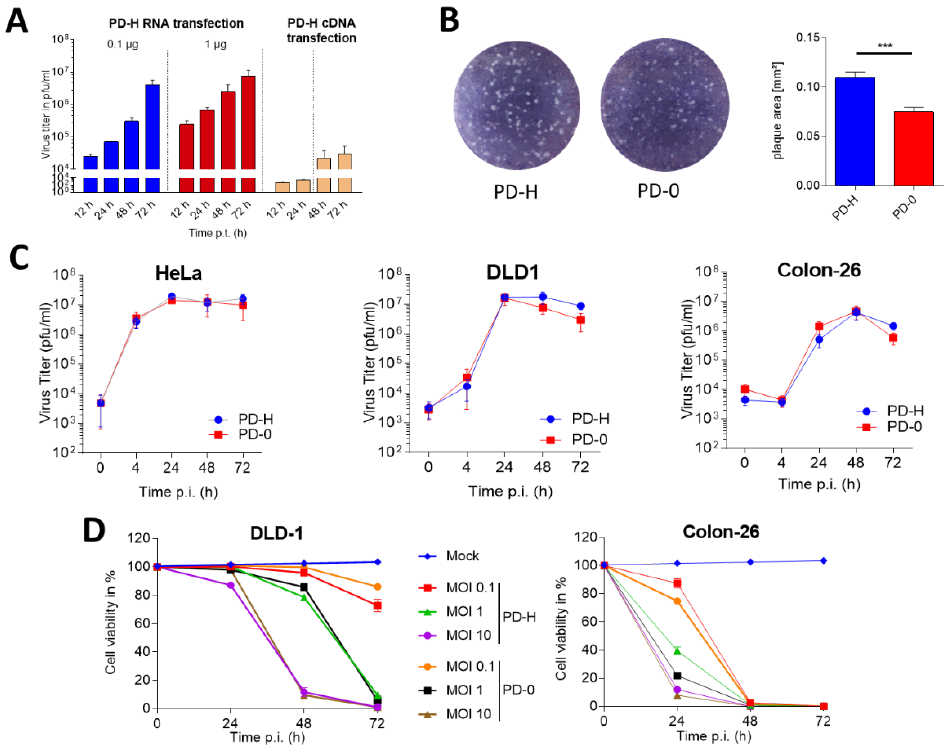
Figure 2. Optimization of production of PD-H and comparison of virus function of PD-H and PD-0. ( A ) CHO-K1 cells were seeded in 6-well plates and transfected with 0.1 or 1 µ g of in vitro transcribed genomic RNA of PD-0 cDNA or with 800 ng pJET-CVB3-PD. The virus titers were determined by plaque assay in HeLa cells at the indicated points in time. ( B ) Plaque morphology and size. Plaques of indicated viruses were determined by plaque assays on HeLa cell monolayers. Left panel: representative images of viral plaques (white dots). Right diagram: plaque diameter of PD-H and PD-0 of 50 counted plaques. Significance: *** p < 0.001. ( C ) Virus growth kinetics. HeLa, DLD-1 and Colon 26 cells seeded in 24-well plates and infected with 0.3 MOI PD-H or PD-0. The amount of virus progeny in whole cell lysates was measured by plaque assay on HeLa cells at indicated time points. ( D ) Cell viability. DLD-1 and Colon 26 cells seeded in 96-well plates were infected with PD-H or PD-0 at the indicated MOIs. Cell viability was assessed 24 h, 48 h and 72 h after infection. Data in diagrams are show as mean values ±